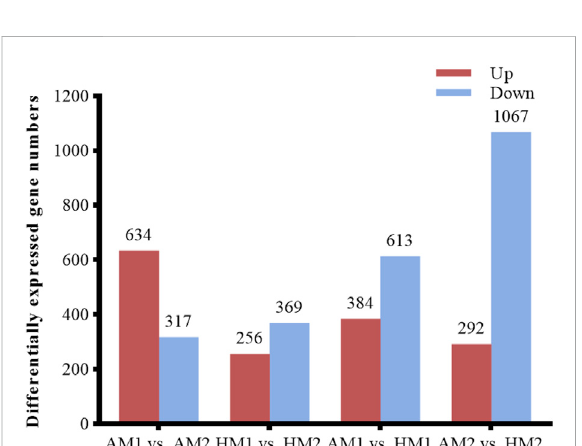
FIGURE 2 The number of up or down-regulated genes in Altay and Hu lambs.AM1vsAM2:muscletissueofAltaylambsat − 5 ° Ccompared with lambs at 20 ° C; HM1 vs HM2: muscle tissue of Hu lambs − 5 ° C compared with at 20 ° C; AM1 vs HM1: muscle tissue of Altay lambs at − 5 ° C compared with Hu lambs at -5 ° C; AM2 vs HM2: muscle tissue of Altay lambs at 20 ° C compared with Hu lambs at 20 ° C.